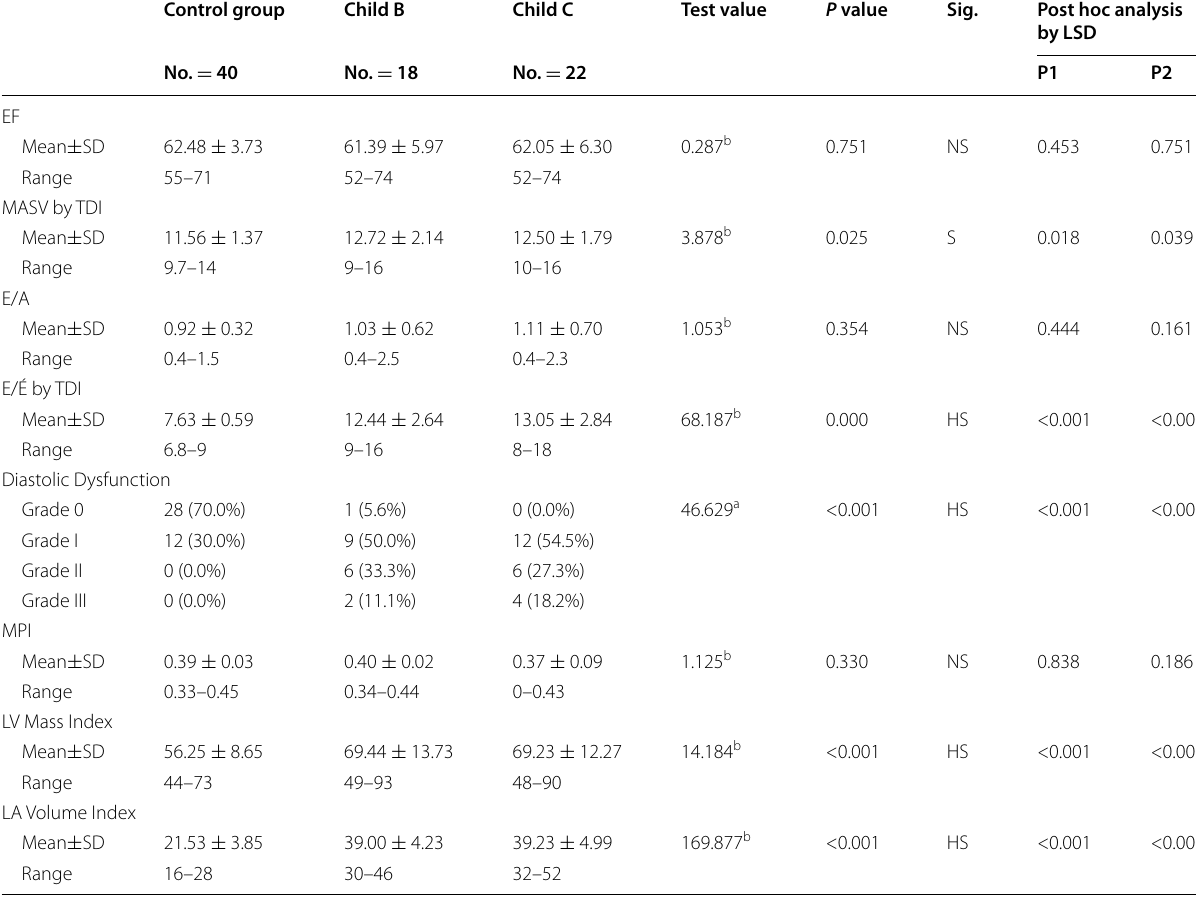
Table 3 Comparison of echocardiographic parameters between controls, child B, and child